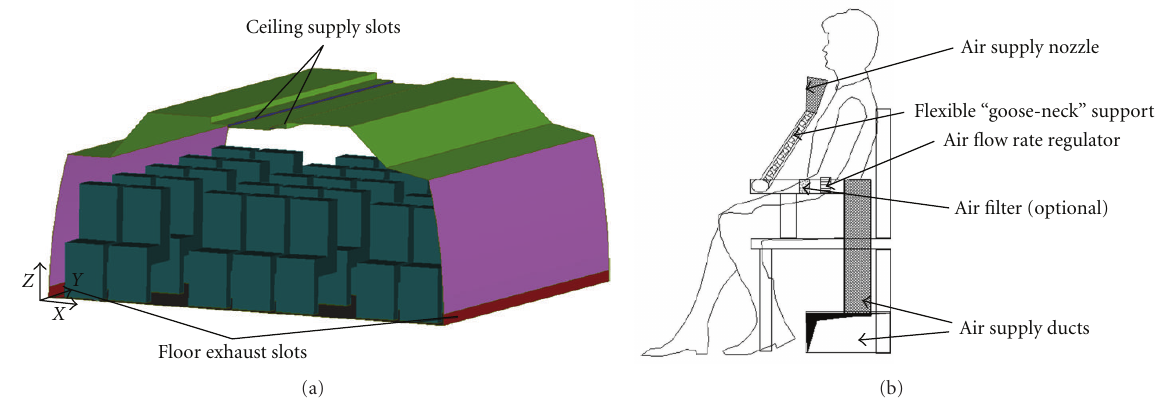
Figure 7: (a) Cabin geometry showing ceiling supply and floor exhaust slots. (b) PV integrated to an aircraft cabin seat armrest [18].